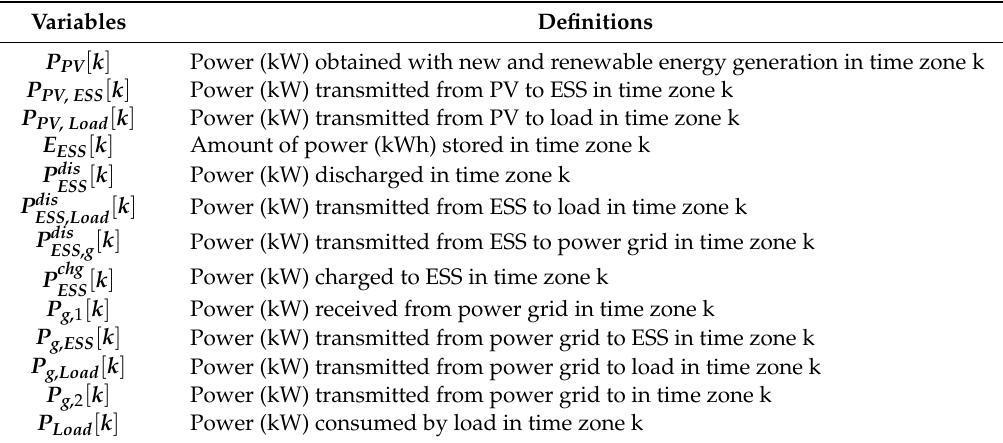
Table 1. Definitions of Variables